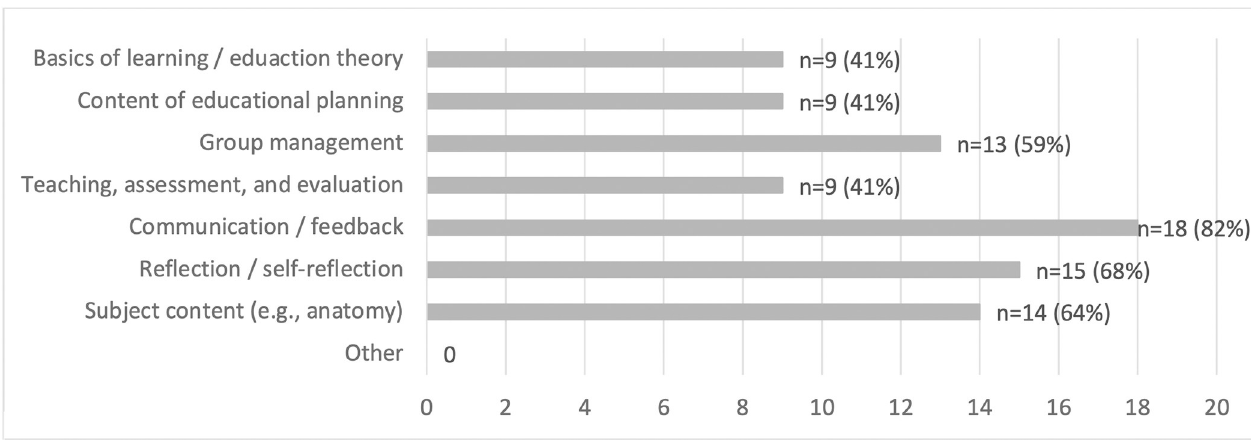
Fig 3. Content of intervention [multiple answer options, sample n = 22].